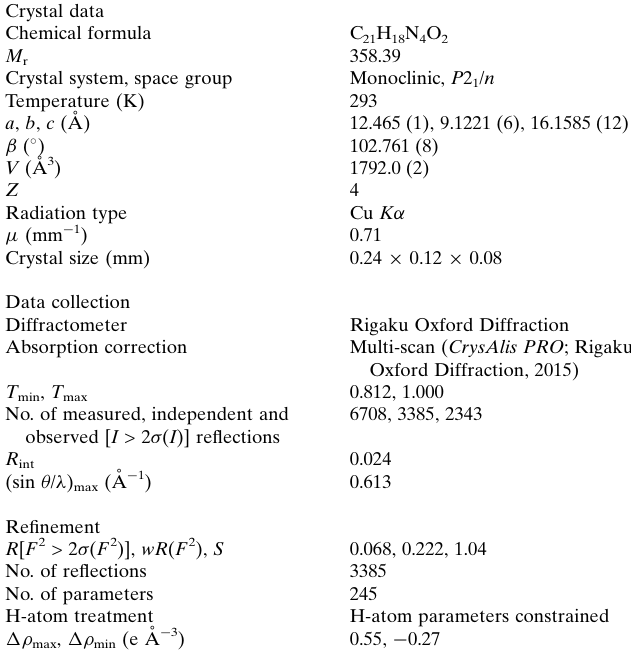
Table 2 Experimental details.